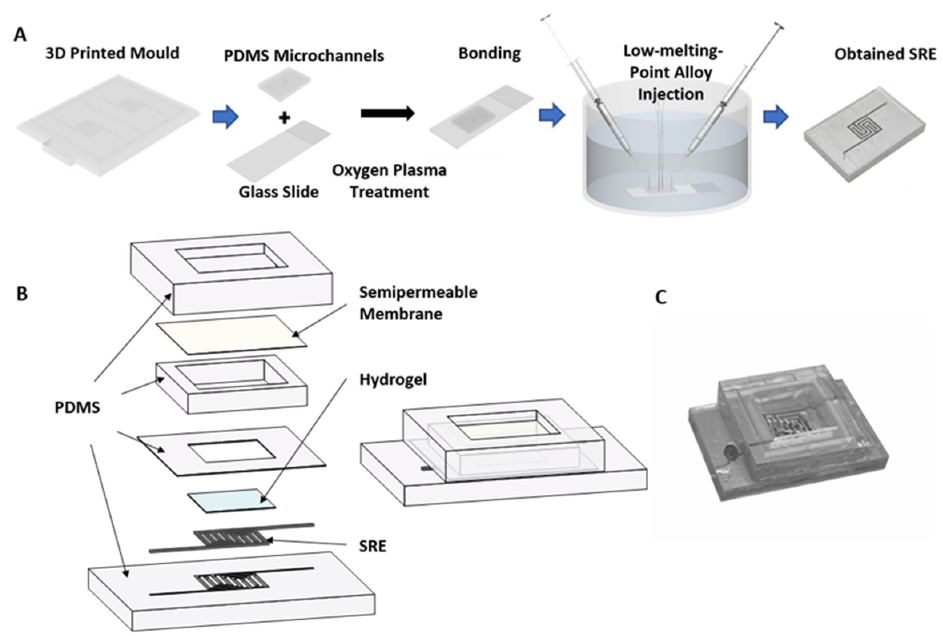
Figure 1. ( A ) Schematic illustration of the fabrication process of the SRE. ( B ) The exploded view and ( C ) the entity of the proposed capacitive glucose sensor.